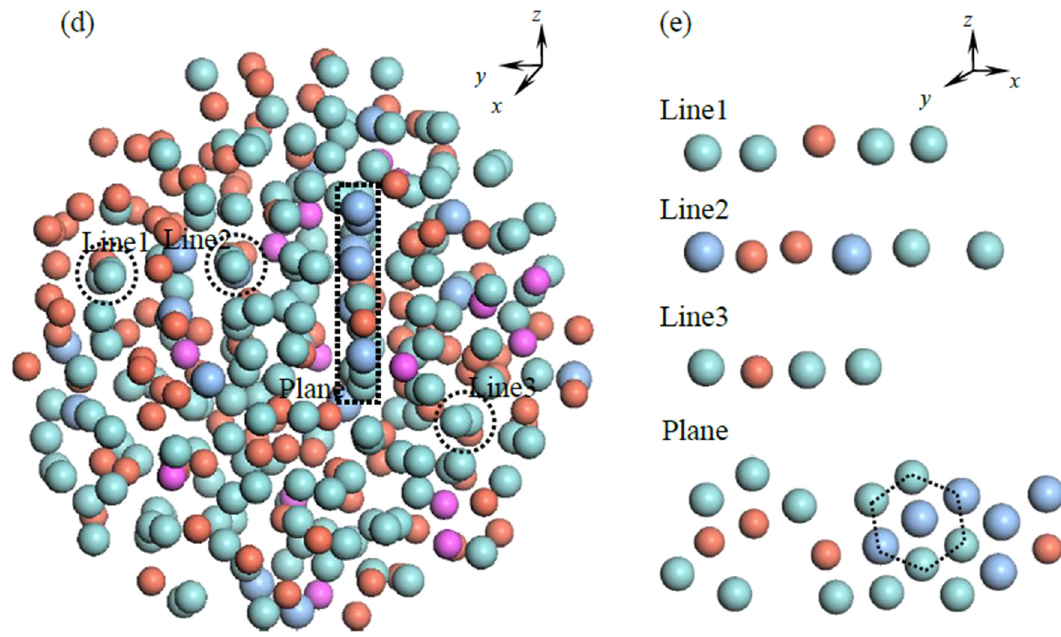
Figure 4. ( a – c ) Typical polyhedra in Zr 48 Cu 36 Al 8 Ag 8 BMG. The Voronoi index and CN are also listed beneath the figures; ( d ) A randomly chosen cluster including four shells; ( e ) Atomic packing structures at medium range with a linear or planar packing type. The visual angle of the figure is defined by Cartesian coordinates, top right. The position of linear or planar packing atoms is marked by dashed circles or square in a four-shell cluster. However, the dashed hexagon marks the densely atomic packing region in the plane. In addition, the linear packing regions containing three atoms are not marked.